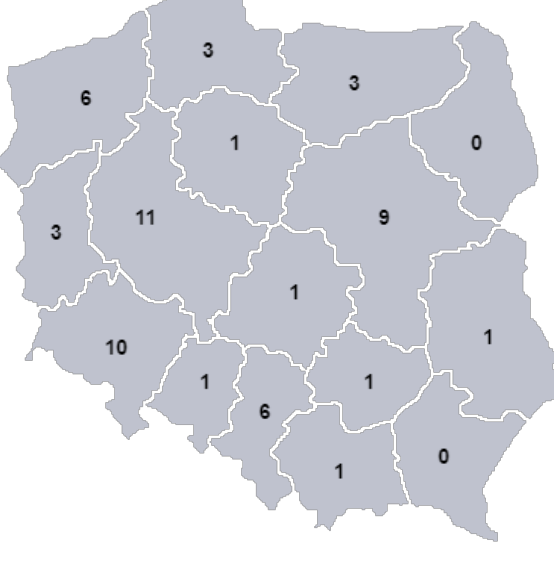
Figure 1. Geographical distribution of songs' origin (N = 78, unidentified = 21). From Contour map of Poland , by Halibutt, 2006,